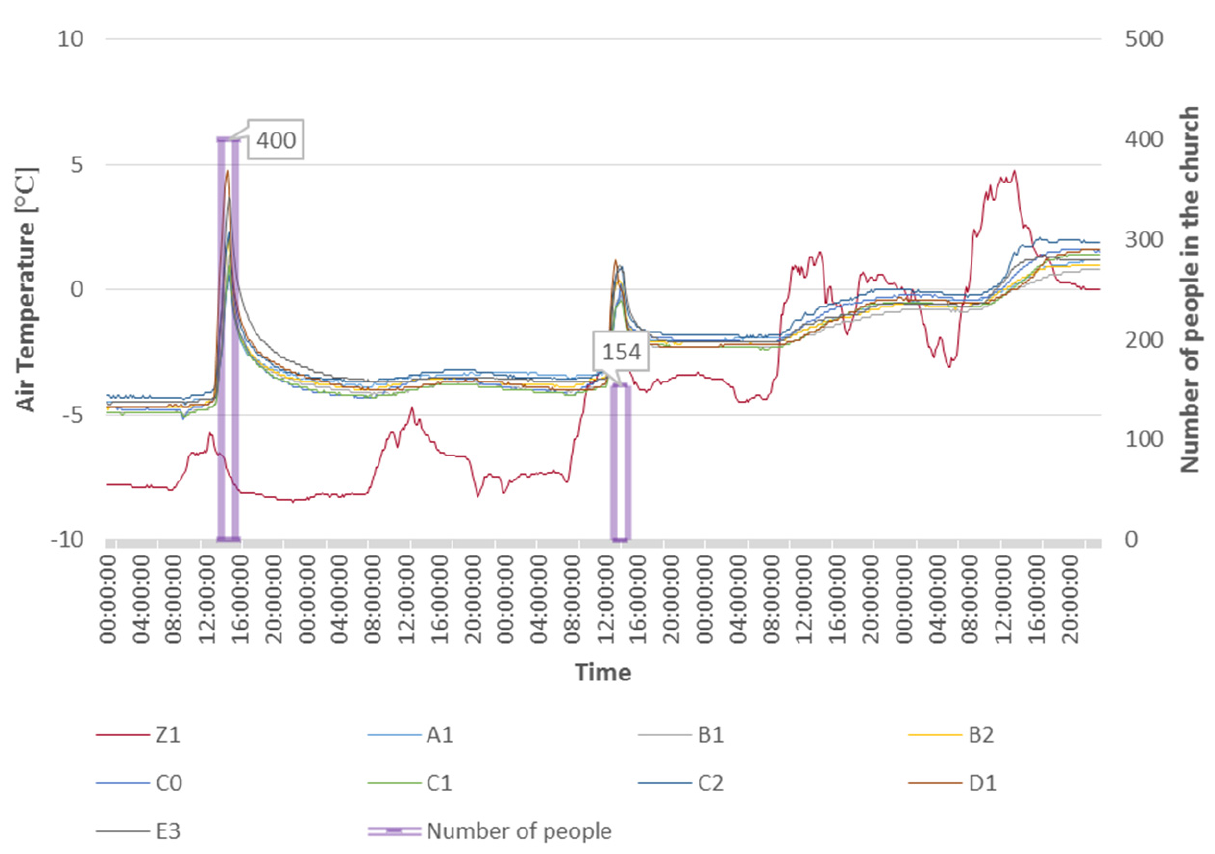
Figure 6. The course of air temperature and relative humidity inside and outside the building, during the winter period (24 January–28 January 2019).